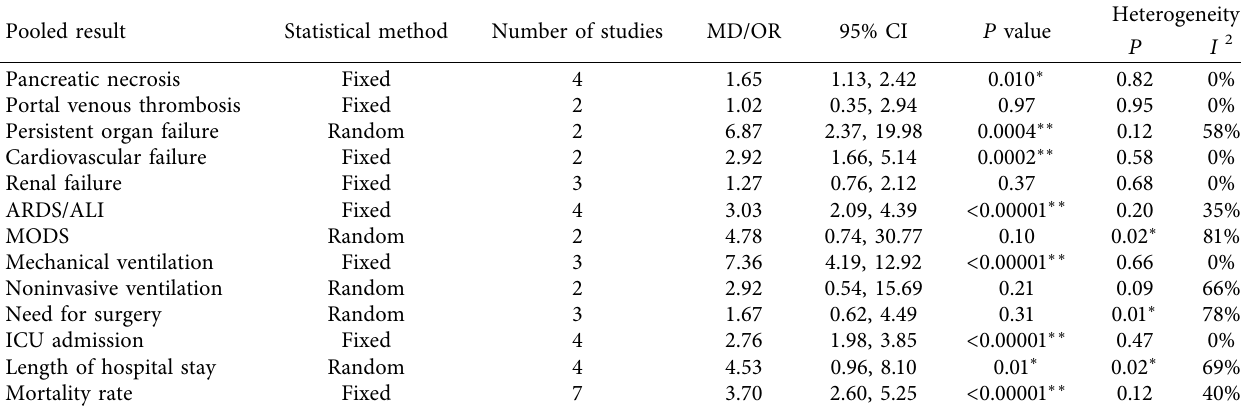
Table 2: Pooled results of clinical